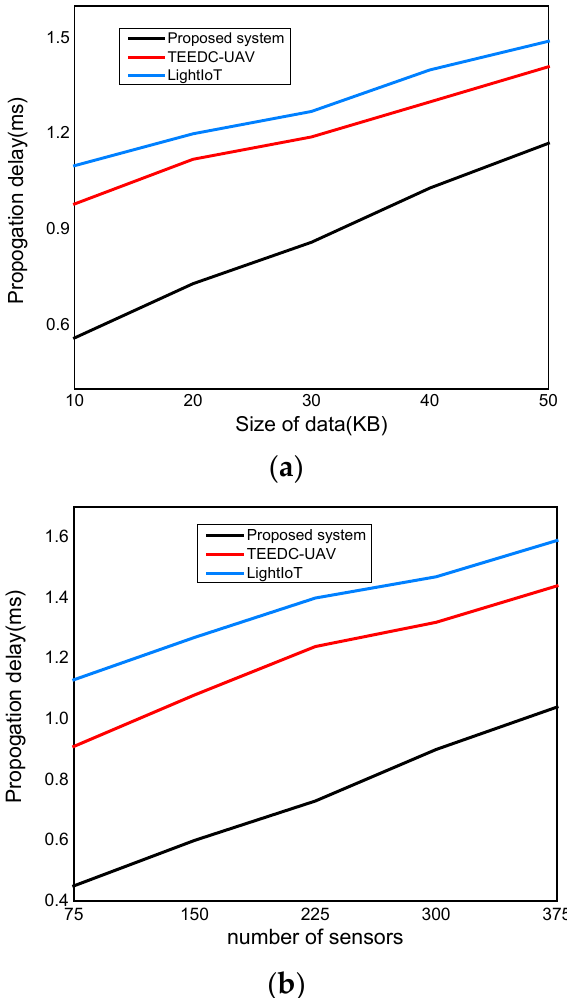
Figure 5. Performance results for varying data sizes and sensors for propagation delay. ( a ) propagation delay with varying data size ( b ) propagation delay with varying number of sensors.